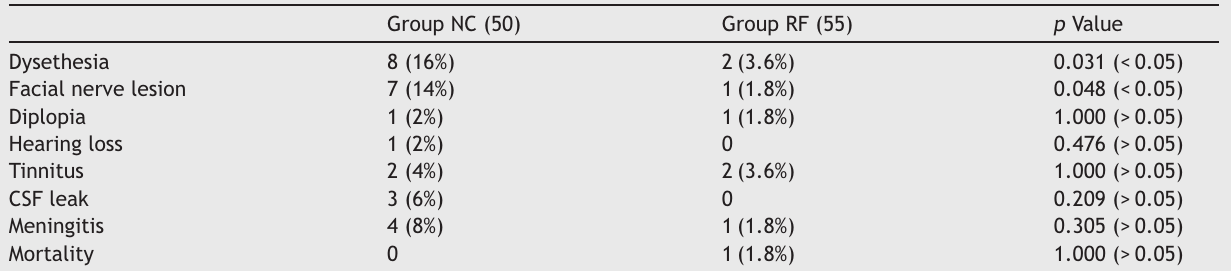
Morbidity and surgical complication rates in the two patient